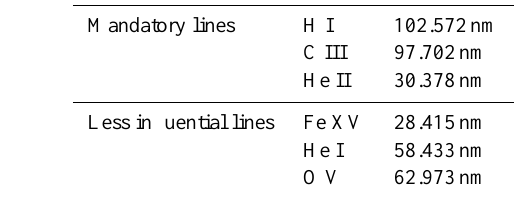
Table 1. The six lines that allow one to specify the ionospheric density, temperature and electron production